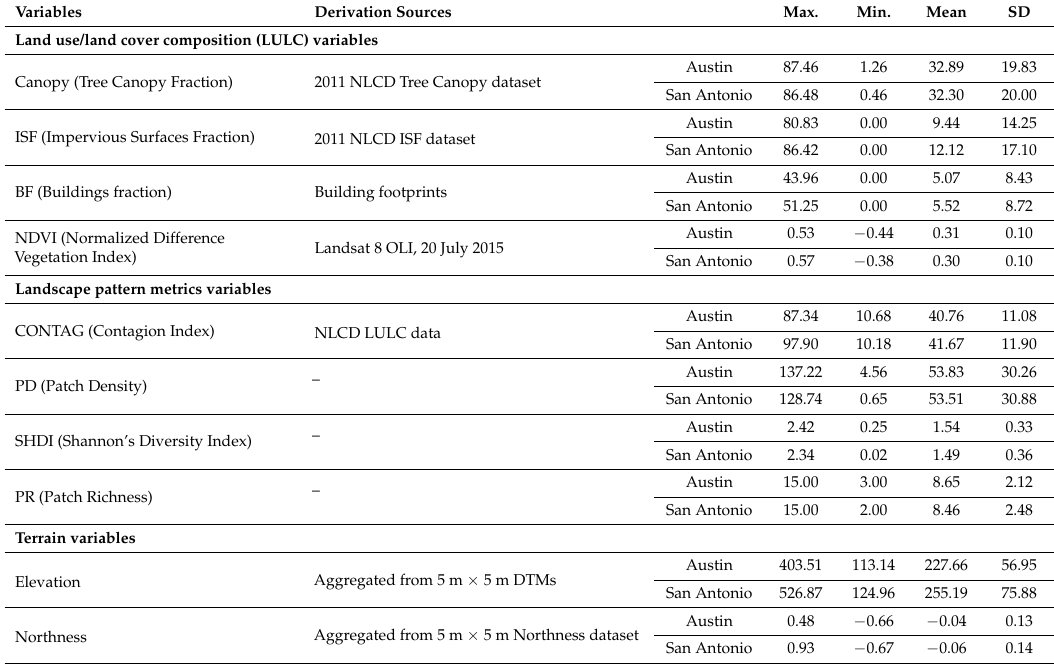
Table 3. Potential explanatory variables: derivation sources and statistical summary of the